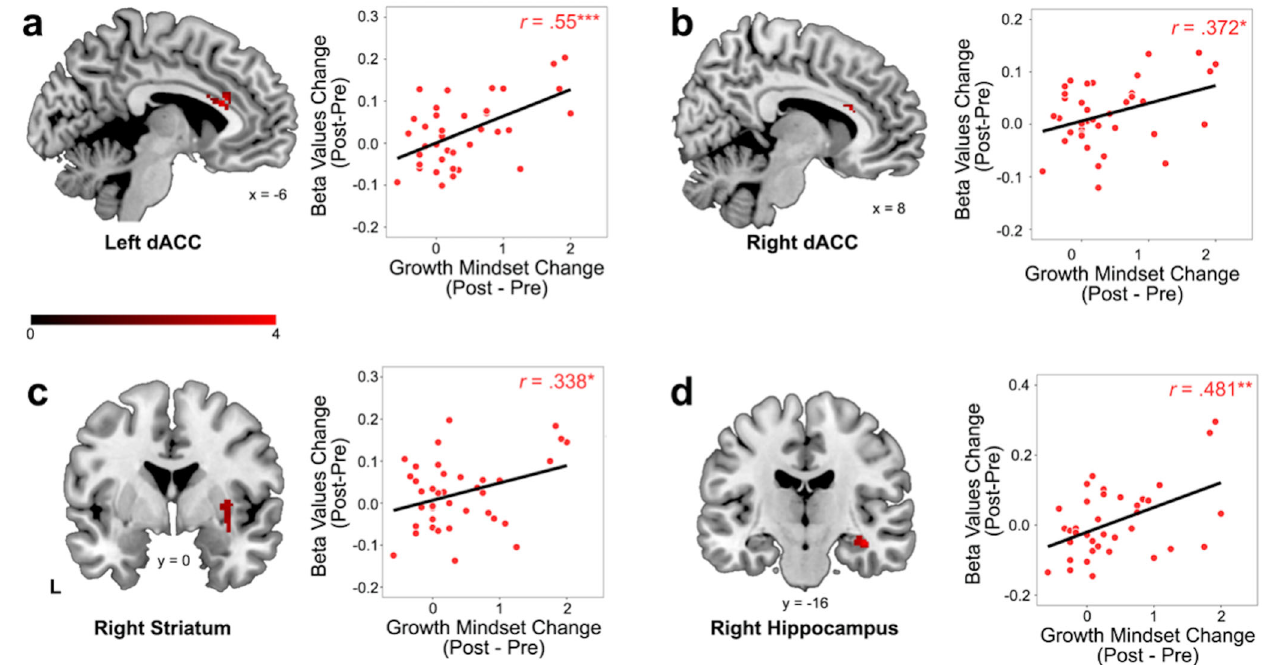
Fig. 2 Plasticity of neural response associated with increases in growth mindset with cognitive training. Training-related increases in brain activation in the dorsal anterior cingulate cortex (dACC) on the ( a ) left and ( b ) right side, ( c ) right striatum (putamen), and ( d ) right hippocampus during more dif fi cult math problem solving are signi fi cantly correlated with growth mindset gains in the training group. Color bar represents strength of association between changes in brain activation and growth mindset gains. Beta values of ROIs were extracted individual links of the right dorsal ACC were positively correlated Table 1. Brain regions showing signi fi cant changes in neural response with changes in growth mindset with training: right dorsal ACC - associated with gains in growth mindset. left dorsal ACC, r (36) = 0.361, p = 0.026 (0.078, FDR-adjusted), and right dorsal ACC - right dorsal striatum, r (36) = 0.449, p = 0.005 (0.028, FDR-adjusted) (Fig. 3c, d; Supplementary Table 8). These